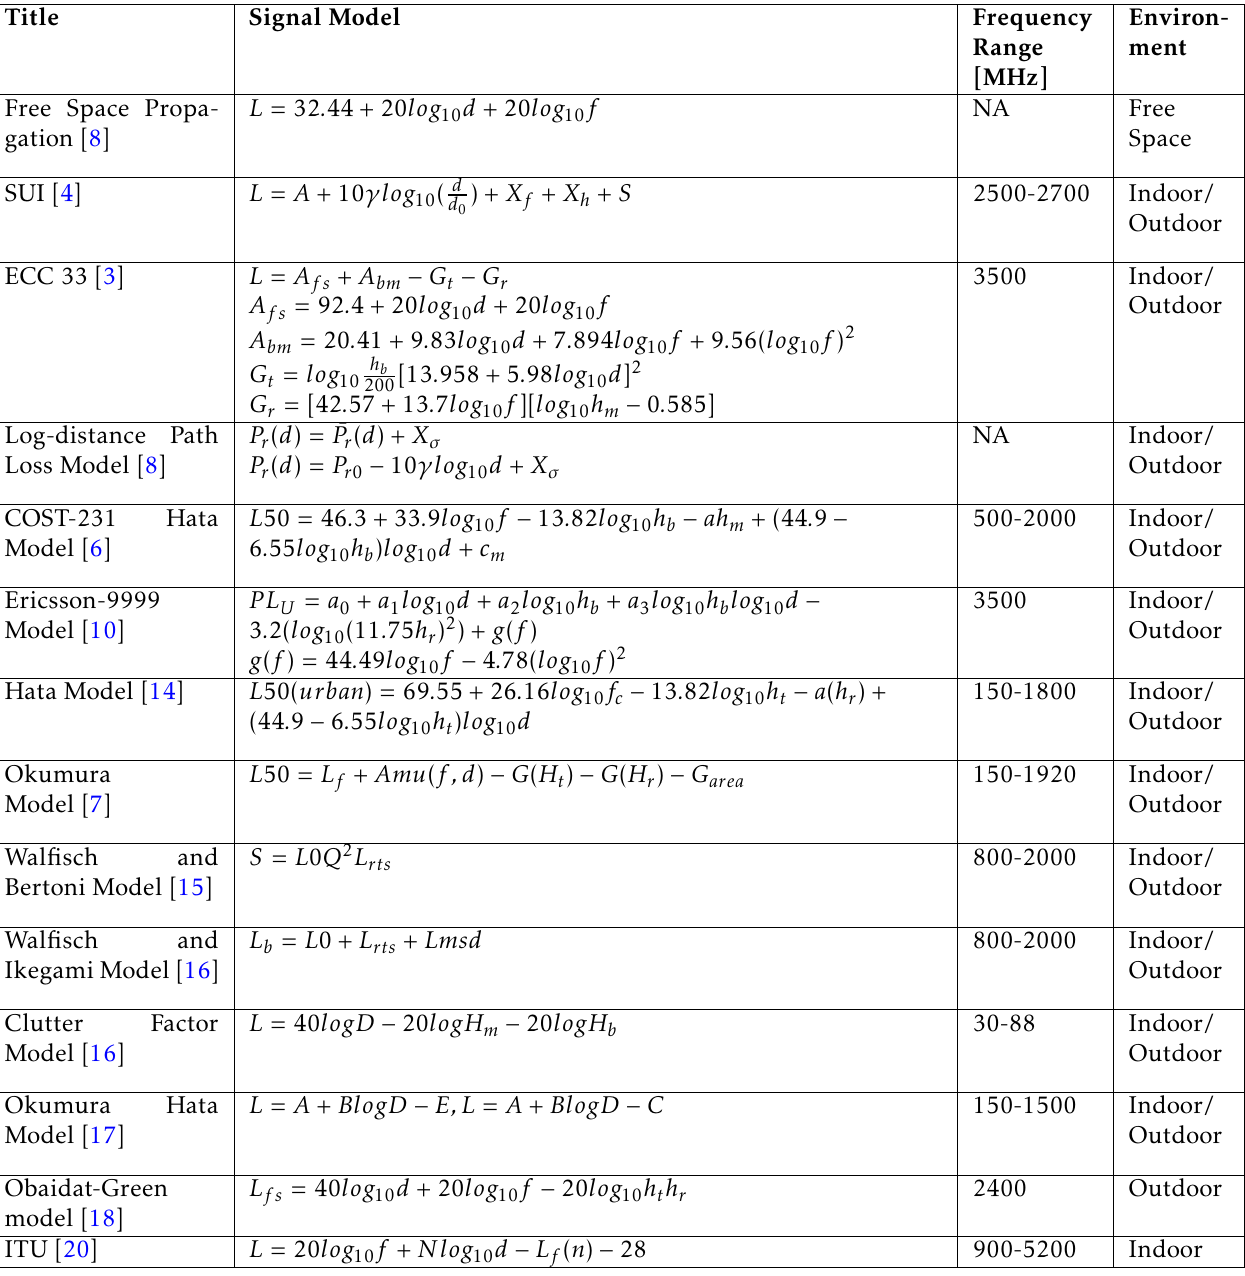
Table 1. Existing Signal Propagation